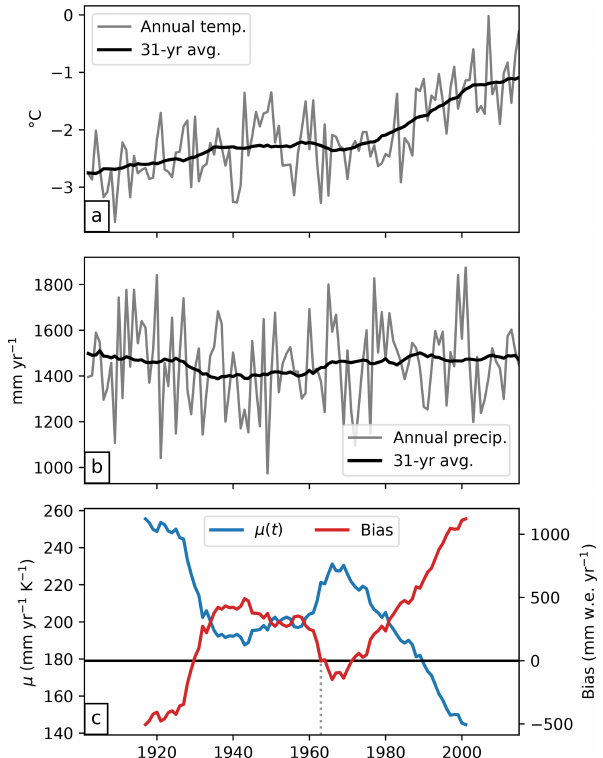
Figure 3. Calibration procedure for µ ∗ applied to the Hintere- isferner Glacier, Austria. (a, b) Annual and 31-year average of temperature and precipitation obtained from the nearest CRU grid point (altitude 2700ma.s.l.). (c) Time series of the µ can- didates (mmyr − 1 K − 1 ) and their associated mass-balance bias (mmw.e.yr − 1 , right axis) in comparison to observations. The ver- tical dashed line marks the time where the bias is closest to zero ( t ∗